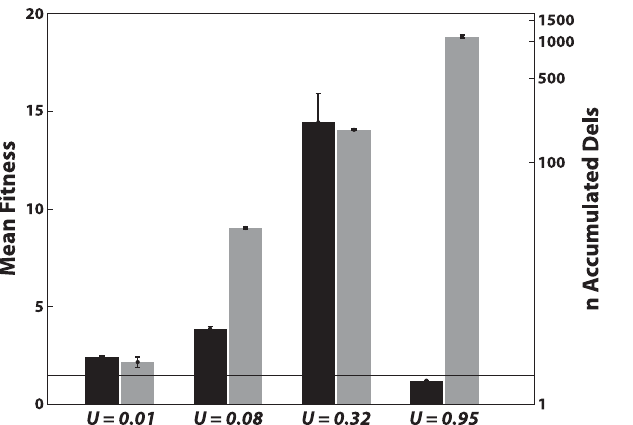
Figure 2. The Mean Fitness of Evolved Populations Increases with Mutation Rate (up to U ¼ 0.32) despite Accumulating Greater Numbers of Deleterious Mutations The dark gray bars (left) represent the mean final fitness of populations that evolve under each mutation rate. The light gray bars (right) show the mean number of deleterious mutations that accumulate during the time to the MRCA of the final population. The error bars represent one standard error from the sample mean. DOI: